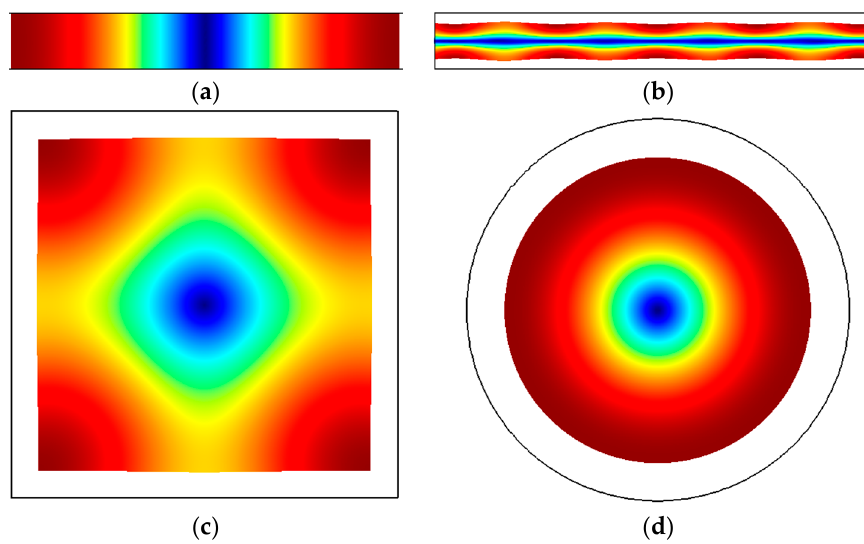
Figure 6. Bulk mode shapes based on rectangular plates, square plates, and circular disks: ( a ) length-extensional (LE) mode, β = 1, λ = 2L; ( b ) width-extensional (WE) mode, β = 1, λ = 2W; ( c ) square-extensional (SE) mode, β = 1, λ = 2L; ( d ) radial breathing mode, β = 1, λ = 2R.